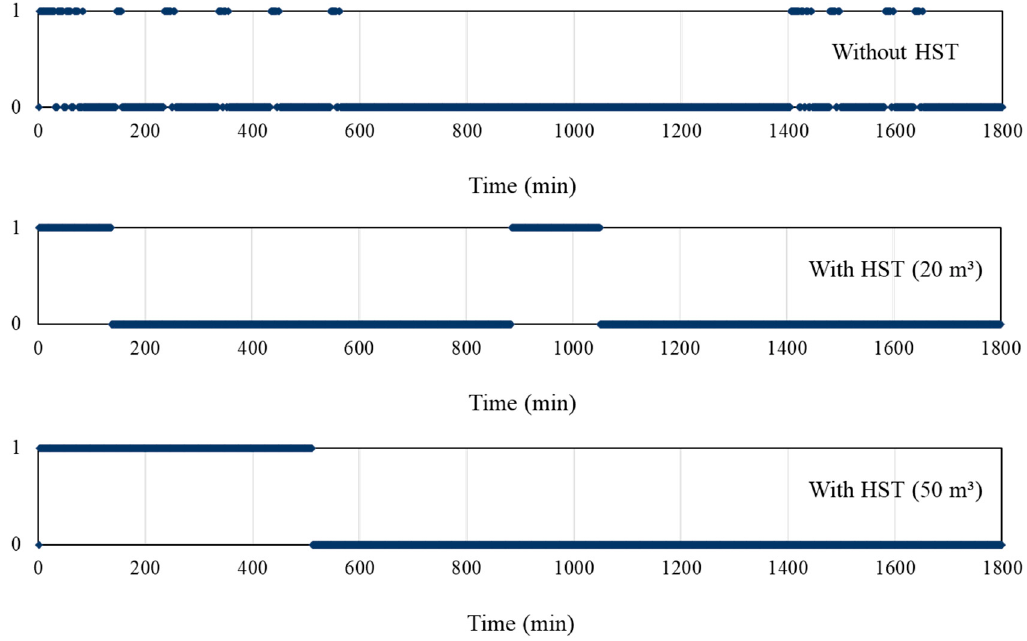
Figure 10. Heat pump operation schedule according to the capacity of HST.